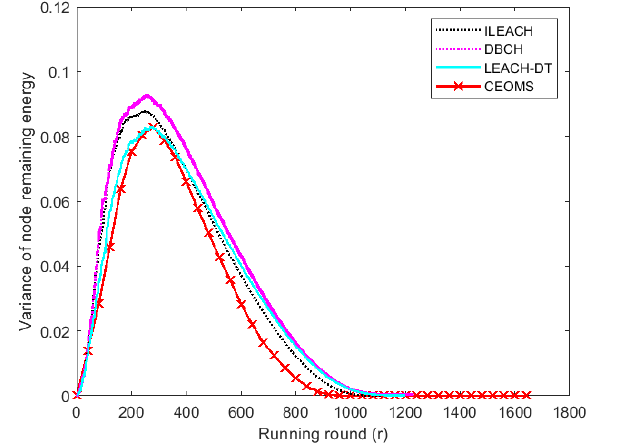
Figure 16. The variance of remaining energy of four algorithms.